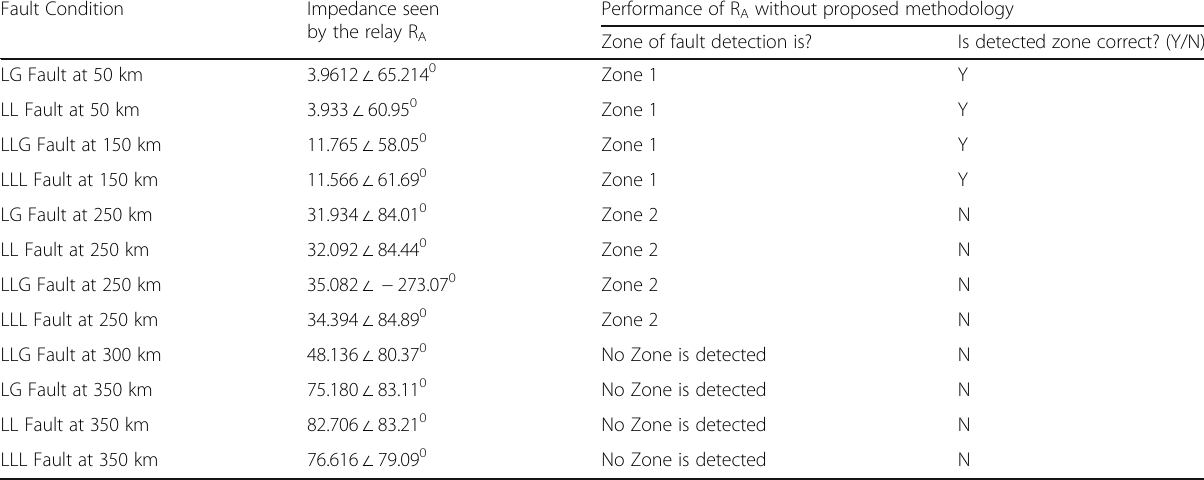
Table 4 Performance of the distance relay R A without PAZSD methodology for different faults with FR = 0.2 Ω at different distances Fault Condition